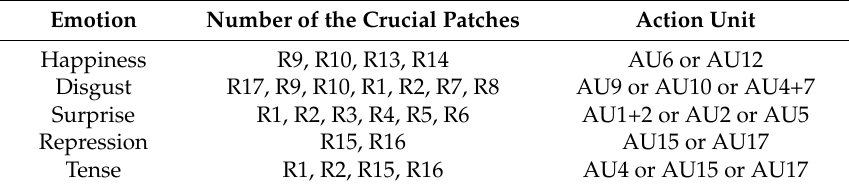
Table 6. NMP of micro-expression in the CASME II